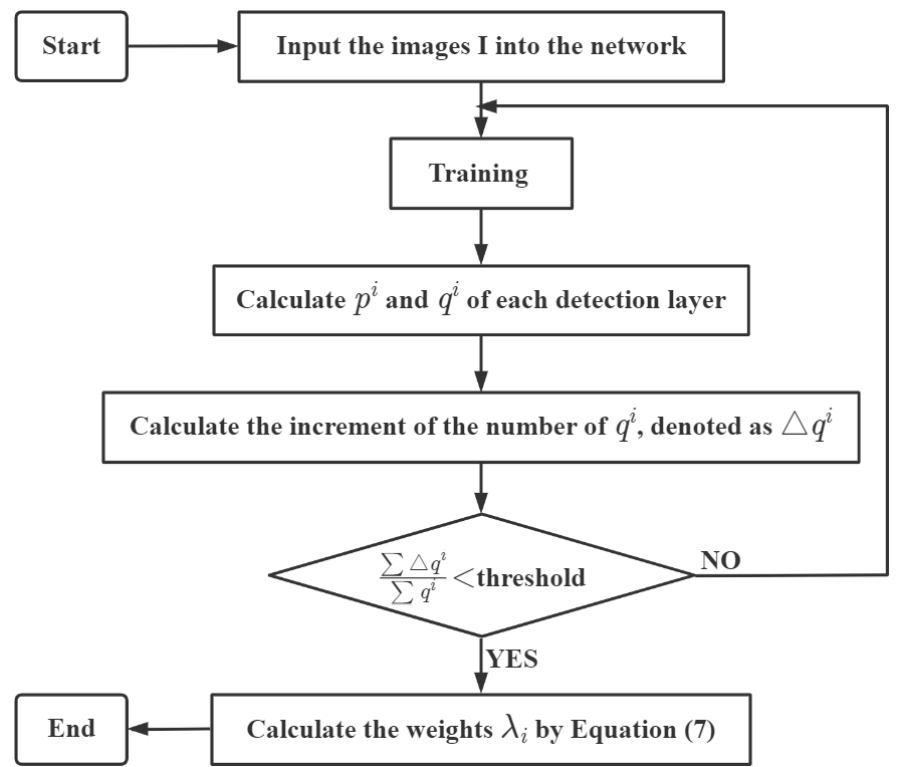
Figure 7. Flow chart of calculation of the confidence loss function